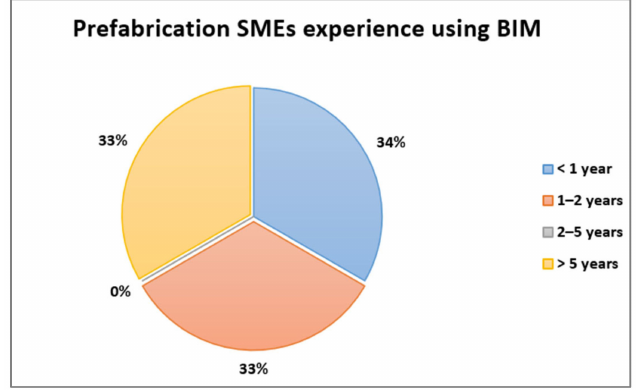
Figure A1. Information about the companies.